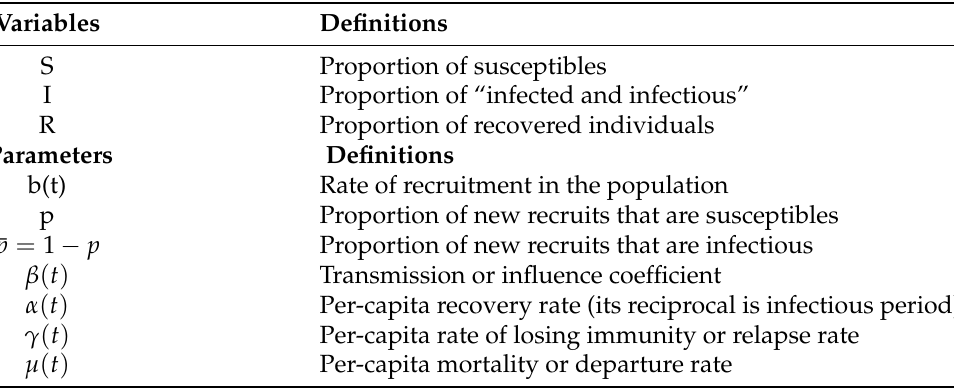
Table 2. Definition of variables and parameters in the model given by Equations (1) and (2).